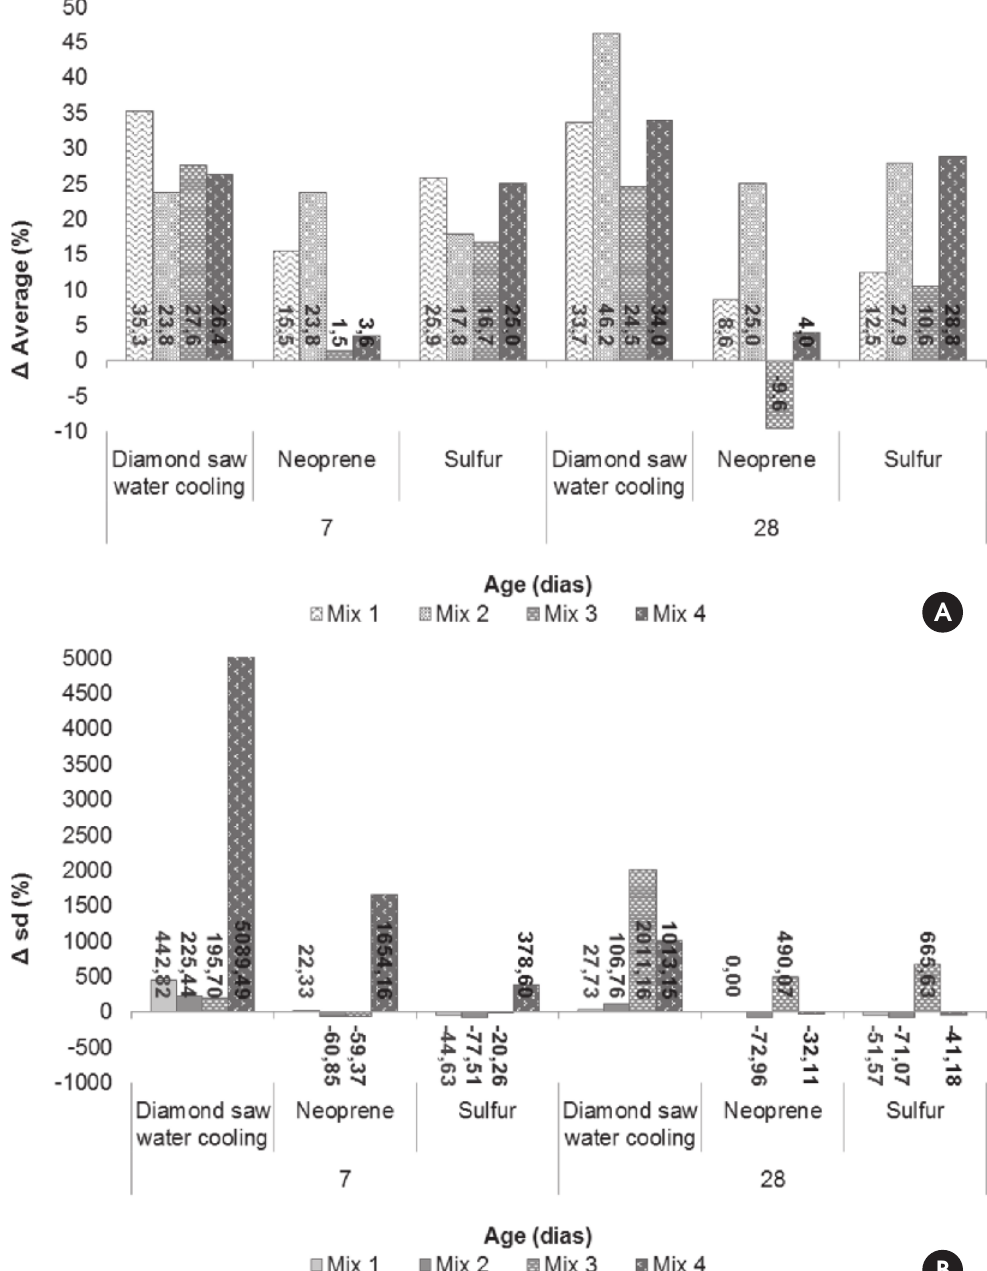
Comparison of surface preparation techniques and the standard established by NBR 5738. a) Comparison of the mean values. b) Comparison of standard deviation